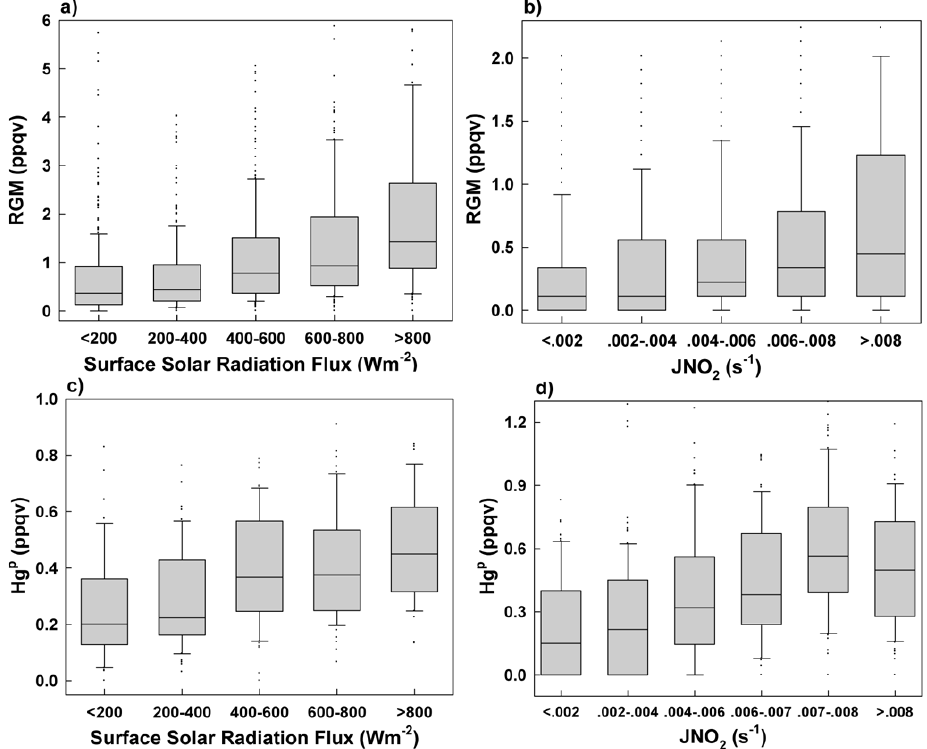
Fig. 6. (a) RGM versus surface solar radiation flux at TF (coastal) in spring, (b) RGM versus j NO 2 at AI (marine) in spring and summer, (c) Hg P versus surface solar radiation flux at TF (coastal) in summer, and (d) Hg P versus j NO 2 at AI (marine) in summer. Only daytime data were